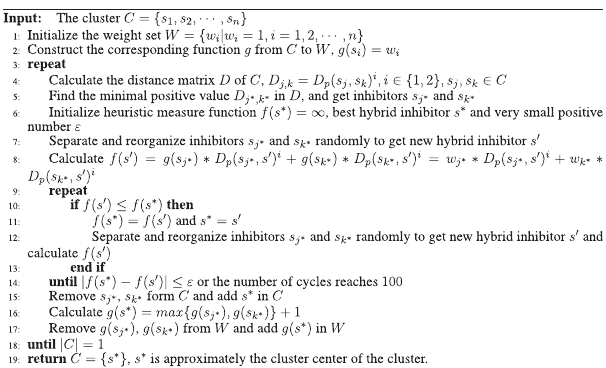
Algorithm 1. Cluster center